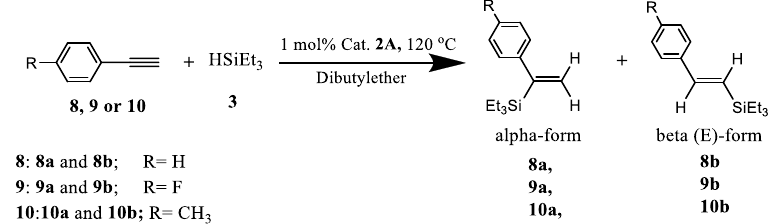
In Scheme 6, the Pt catalyst 2A -catalyzed hydrosilylation of phenylacetylene ( 8 ) with triethylsilane ( 3 ) for 1~3 h under thermomorphic condition afforded two isomers, α -form 8a and β -( E )-form 8b with an estimated ratio of 2:1 according to GC-MS analysis. The characteristic 1 H-NMR signals (see Figure S9 ) for the geminal alkenyl protons of α -form 8a appear at 5.6 ppm (d, J = 3 Hz) and 5.9 ppm (d, J = 3 Hz), and the signals for the trans position protons of ( E )-form 8b show at 6.4 ppm ( J = 18.9 Hz) and 6.9 ppm ( J = 19.5 Hz) . Most of the ratios of 8a and 8b determined by the integration of 1 H-NMR spectrum are close to 2:1.